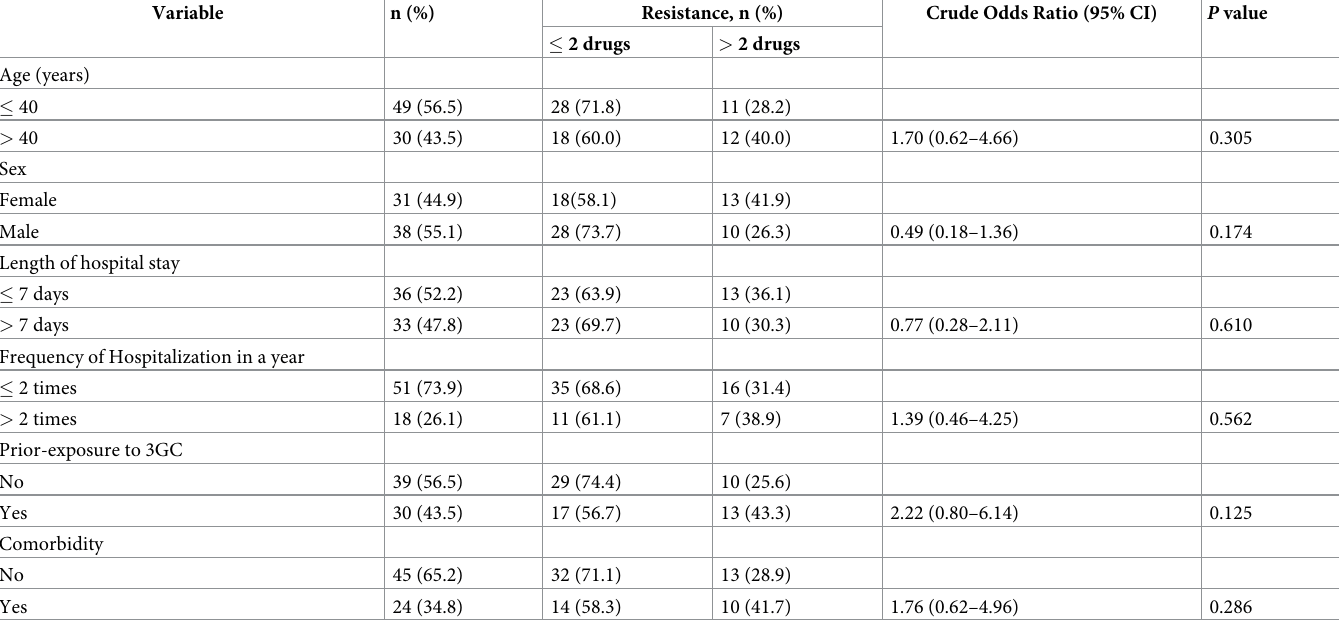
Table 4. Bivariate logistic analysis of differences in resistance to third generation cephalosporins.